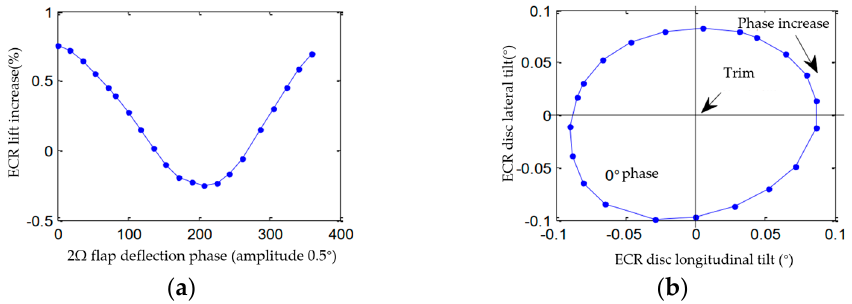
Figure 10. The effect of change in the 2 Ω flap phase on the lift and disc tilt angle of the ECR. ( a ) Lift. ( b ) Disc tilt angle.